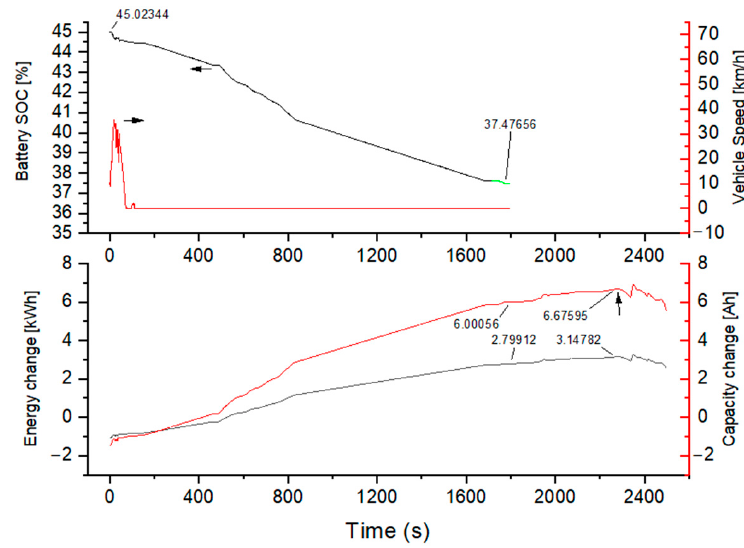
Figure 4. Charging data during transfer.